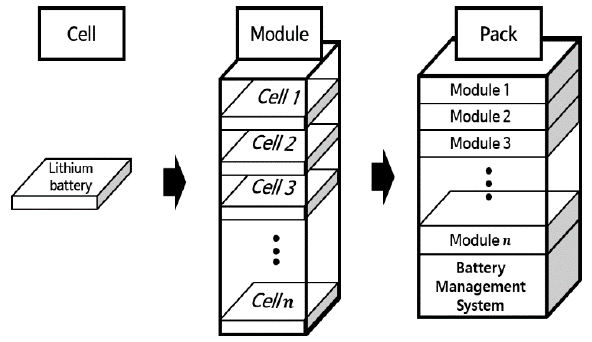
Figure 1. Correlation among the cell, module, and pack of the lithium battery.